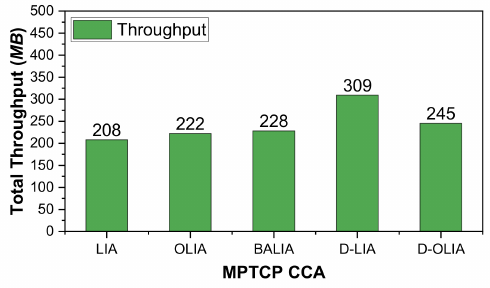
Figure 7. Performance analysis of the considered MPTCP-CCAs for Scenario #2 in terms of total